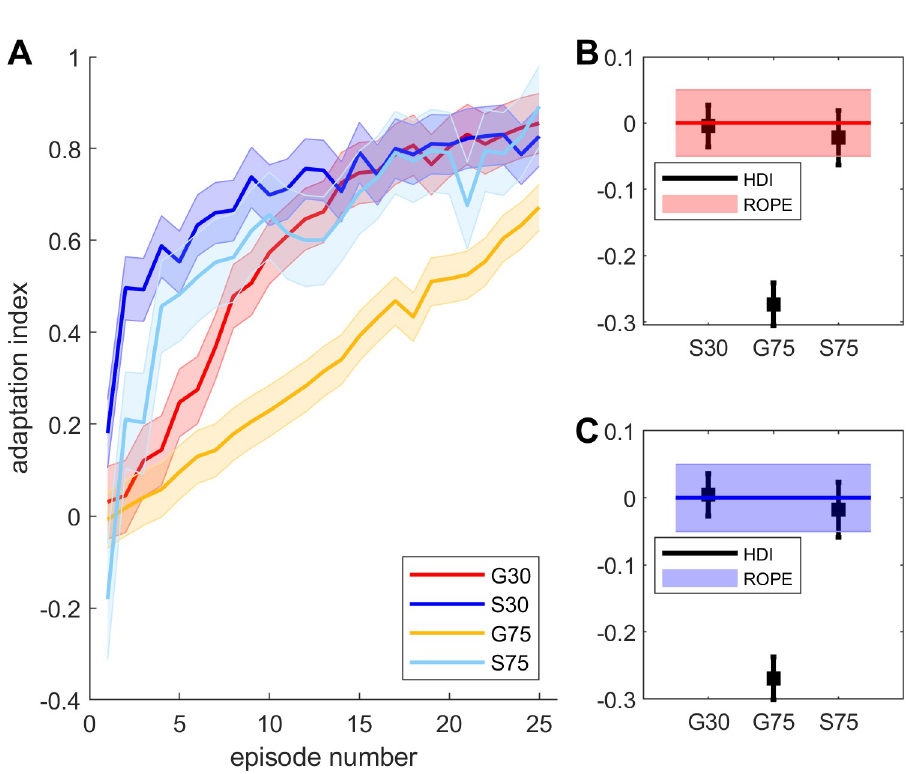
Fig 3. Adaptation. Group means and their HDIs of posterior probability distributions for adaptation indices (A). Average difference from G30 (B) and S30 (C) of the last ten adaptation bins.